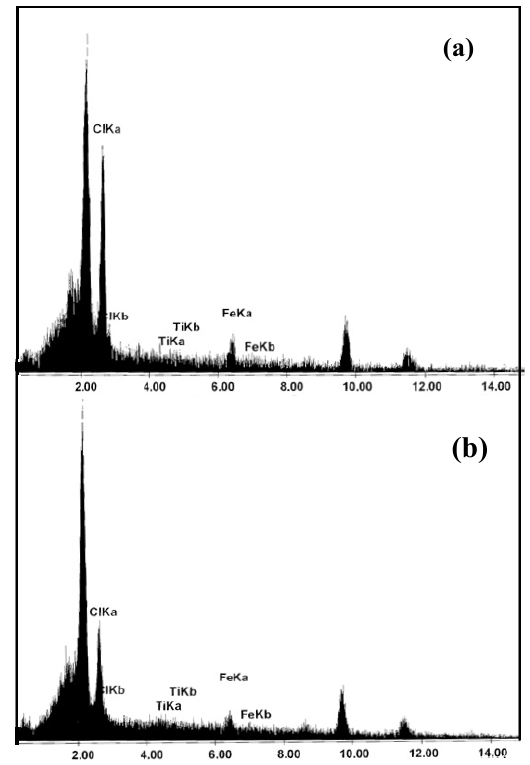
Fig.3: EDX analysis of (a) polypyrrole/titanium dioxide composite and (b) polypyrrole/titanium dioxide nanocomposite (with PVA).